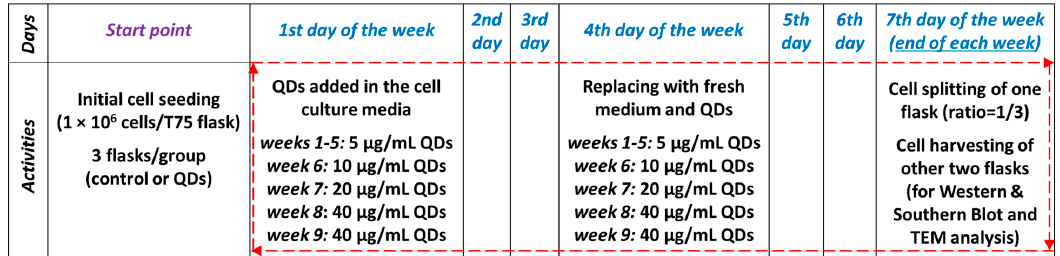
Figure 1. Characterization of Si/SiO 2 quantum dots (QDs) by TEM ( a ), EDXS ( b ) and SEM (scale bar of 20 µm ( c ) and scale bar of 1 µm ( d )) investigations. Note the spherical shape of QDs marked by yellow dot circles ( a ) and the presence of individualized spherical silicon mono-crystals of nanometer sizes marked by orange dot squares ( d ).